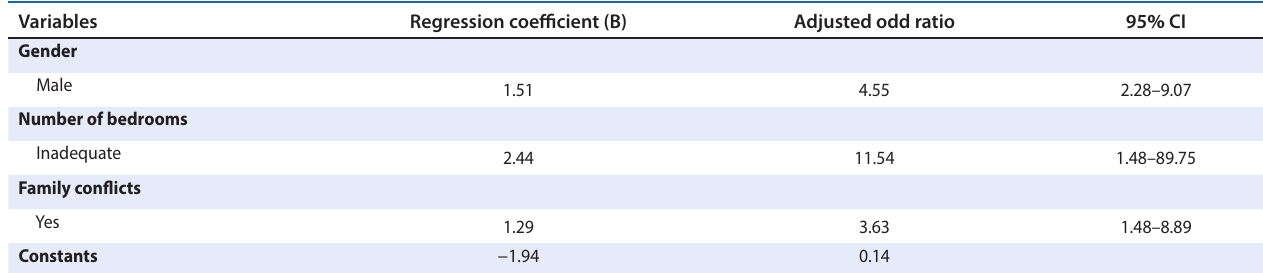
Table 4: Predictor factors towards risk taking behaviour among rural adolescents Variables